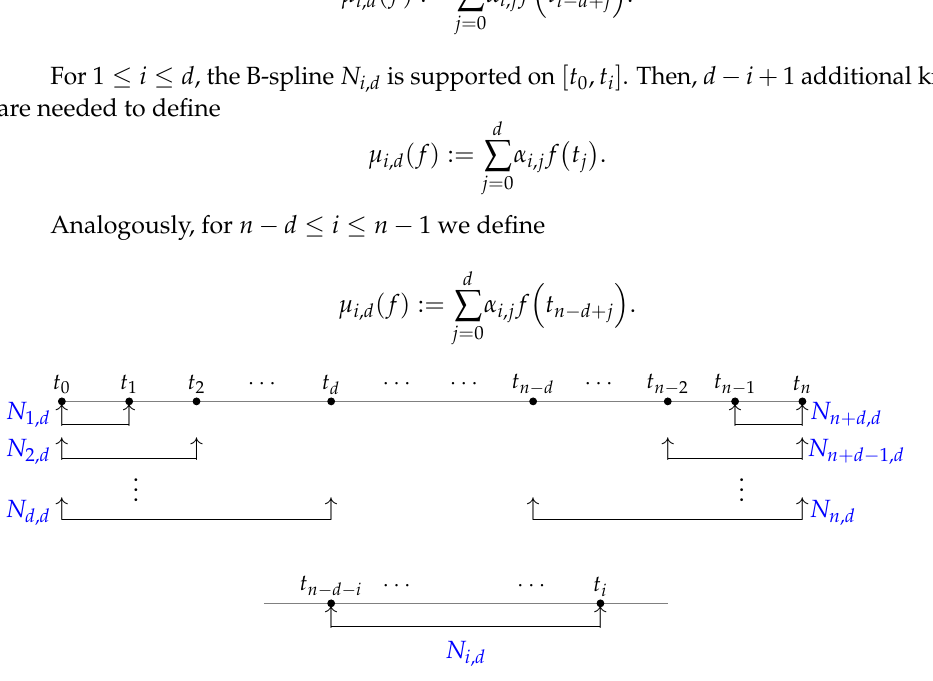
Figure 5. Supports of the B-splines defined on an extended partition with multiple